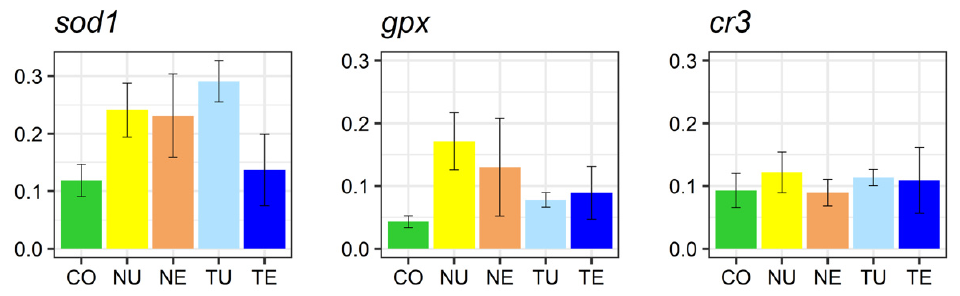
Figure 2. Relative expression of antioxidant and immune-related genes. Shown are the expression of sod1 , gpx and cr3 in the distal intestine of Atlantic salmon fed on different diets (CO, NU, NE, TU, TE) (n = 4 per diet).